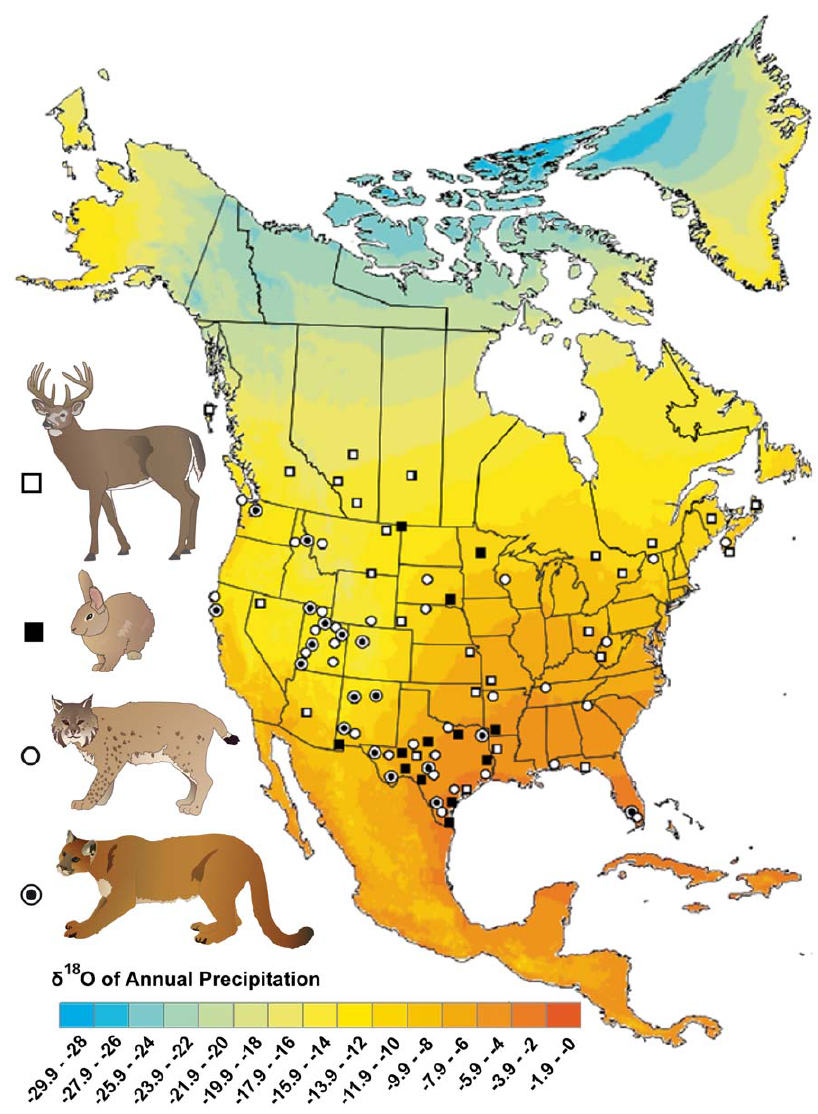
Figure 1. Map of sampling sites. Sample locations for both felines bobcat (n=45) and puma (n=30) as well as their preferred prey species eastern cottontail rabbit (n=13) and white-tailed deer* (n=31), respectively, plotted on the d 18 O precipitation map of North America** (*data from [56]; **from http://www.waterisotopes.org).